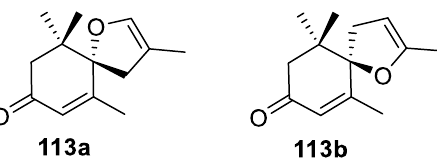
Figure 50. Enantiomers of [4.5.0] spirocyclic dihydrofuran 8,9-dehydrotheaspirone reported in the literature.